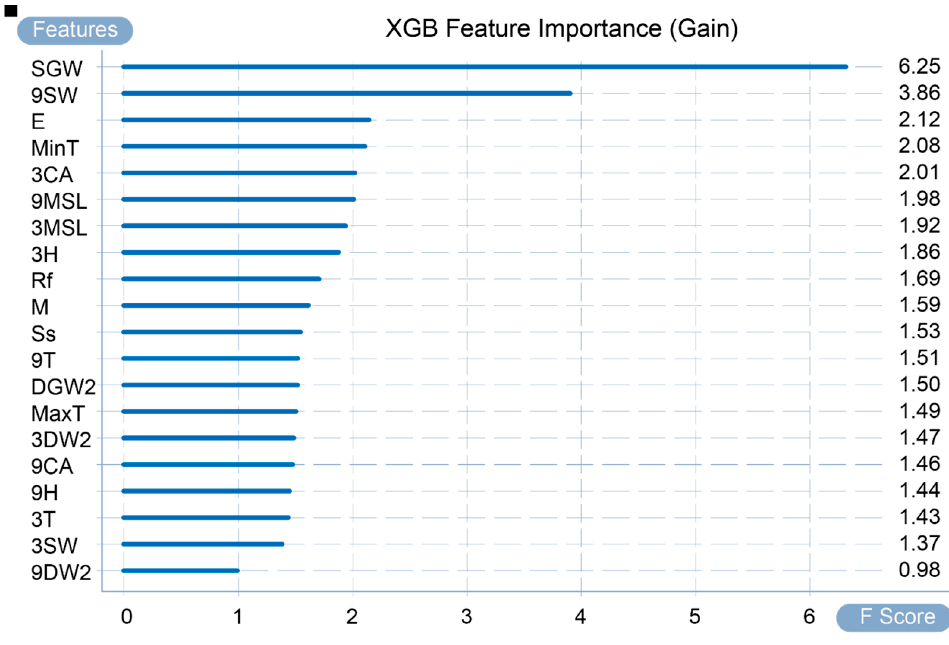
Figure 6. Feature importance by gain.